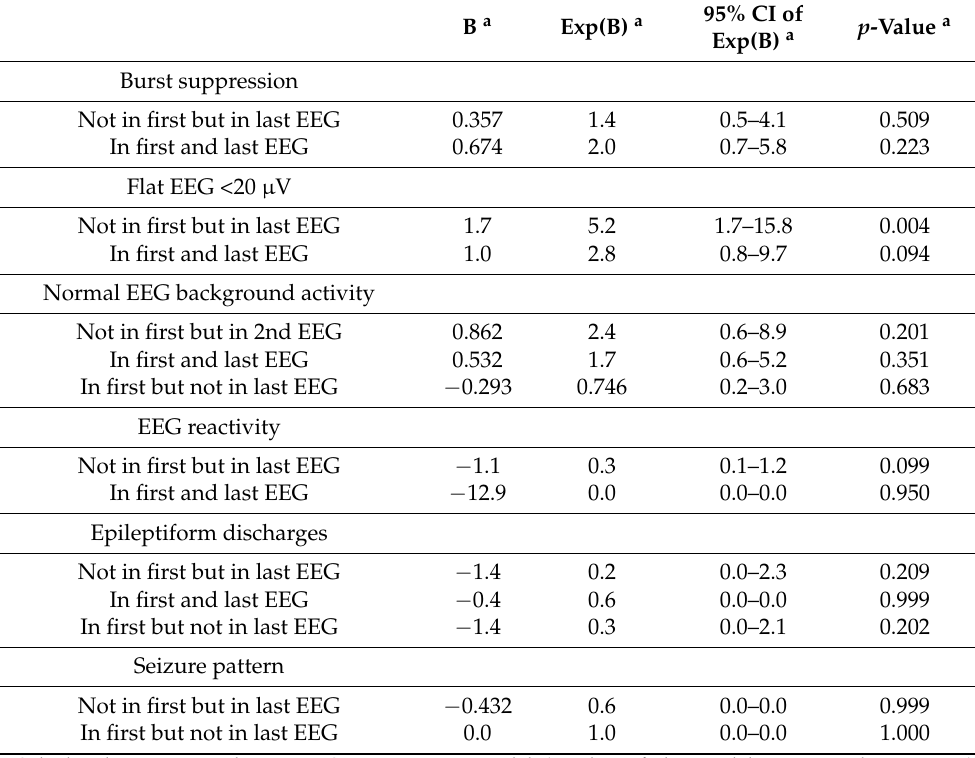
Table 4. Multivariate Cox regression analysis of EEG parameters in patients with HE after